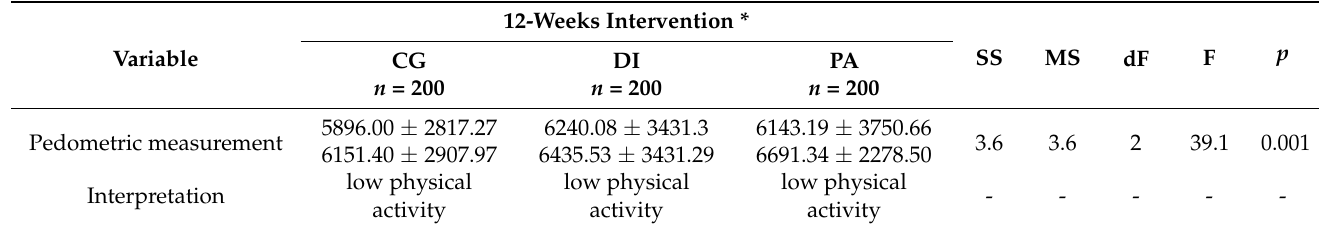
Table 2. Level of physical activity—differences between groups (measurement from pedometers)— n = 600.